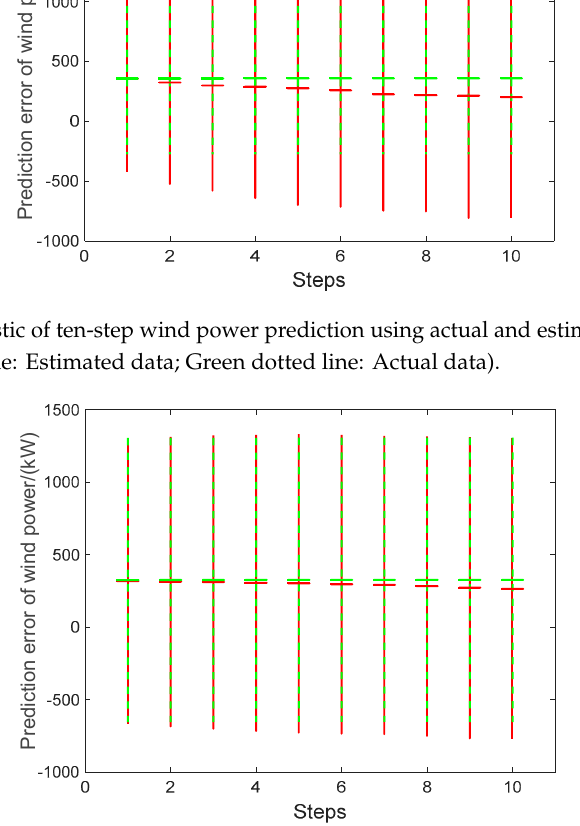
Figure 15. Error statistic of ten-step wind power prediction using actual and estimated wind speed via Gaussian method (Red line: Estimated data; Green dotted line: Actual data).